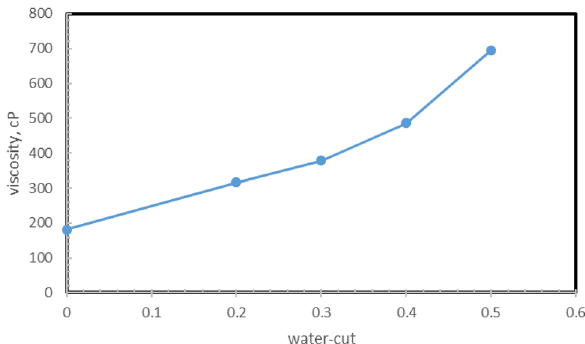
Figure 5. Effect of water-cut on the viscosity of the